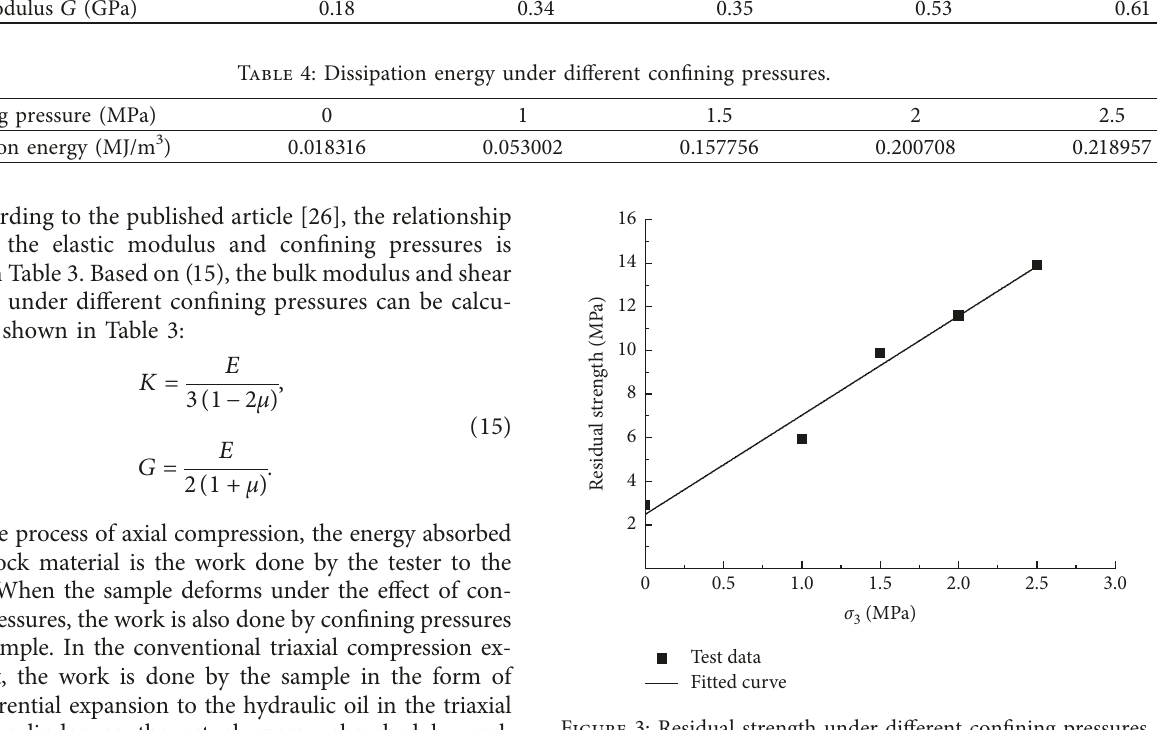
Figure 3: Residual strength under different confining pressures.